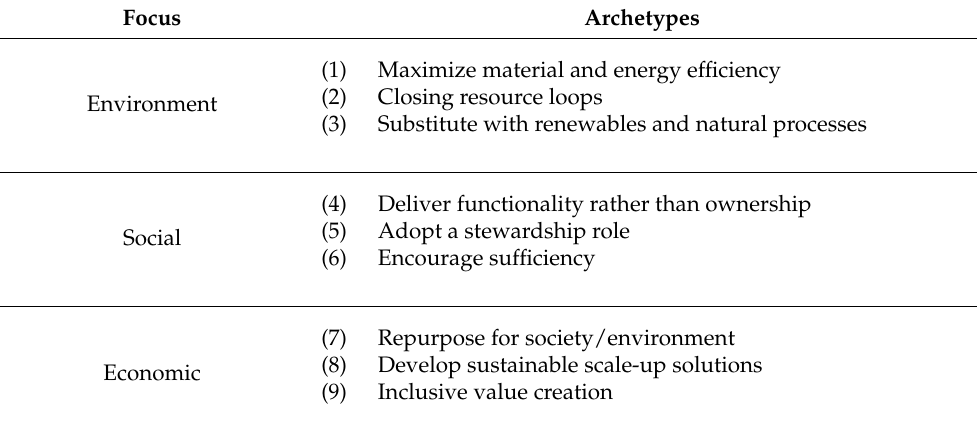
Table 3. Sustainable business model